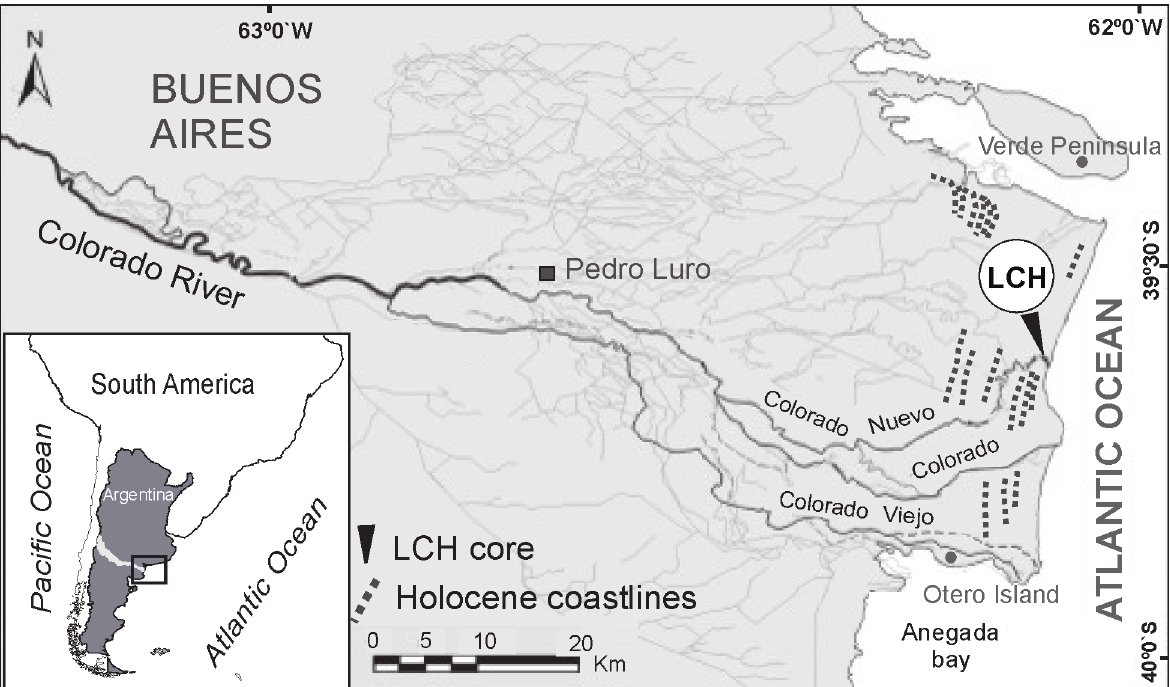
Figure 1. Location map of the Colorado River Basin, Argentina. The study site “La Chiquita” (LCH) is located at the deltaic plain (1.2 km from the coast). Dotted lines: Holocene’s coastline positions (Modified from Codignotto & Weiler